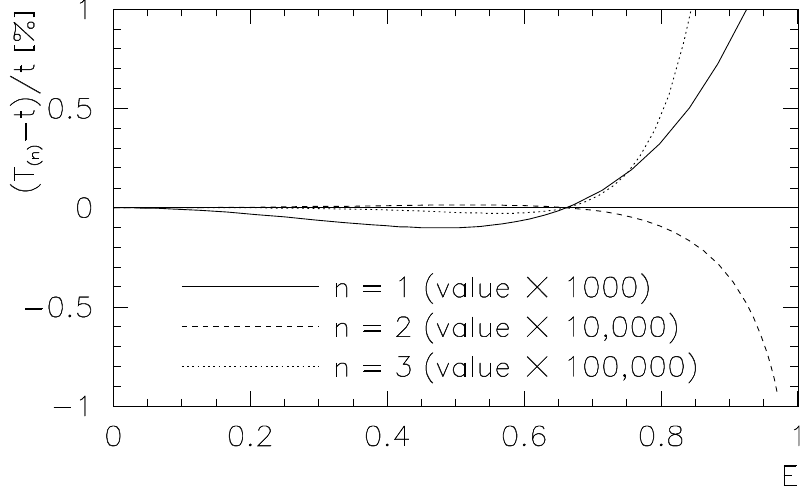
Figure 2. Relative deviations for the dynamical approximations (the degree was set as p =